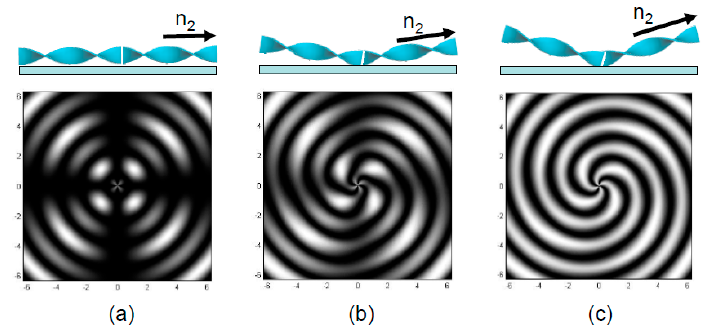
Figure 14. Simulated POM pattern of a spherulite consisting of twisted lamellar crystals with biaxial birefringence. The tilting angle of the lamellar crystals toward the glass slide is ( a ) 0°; ( b ) 15°; ( c ) 30°. The three refractive indices of the crystals are arbitrarily chosen as: n 1 = 1.45, n 2 = 1.5, n 3 = 1.57. The n 2 axis of the crystals are along the radial direction. The sample thickness is set as six times the wavelength of the transmitted light. Adapted from Ref. [14].